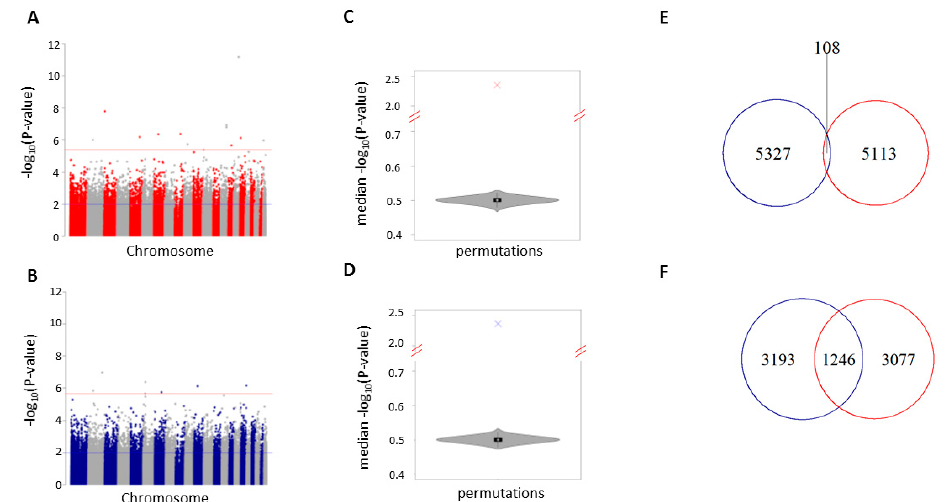
Figure 1. Fruit and juice epigenetic signatures. Manhattan plot of the 325,963 CpG sites in our analysis of fruit ( A ) or juice ( B ) -associated DNA methylation. The y-axis is the − log10 P -value of our regression analysis. − Log 10 P -values (y-axis) correspond to degree of correlation between DNA methylation and fruit consumption. The red line corresponds to a false discovery rate (FDR) threshold of 10%. The blue line corresponds to low P -value CpG sites ( P < 0.01). Violin plot showing the distribution of median permutation P -values ( N = 10,000) for the 5,221 and 5,434 shared CpG sites from fruit ( C ) and juice ( D ) analyses. Venn diagram depicting the number of shared and independent CpG sites ( E ) or genes ( F ) between fruit (red line) and juice (blue line) analyses.